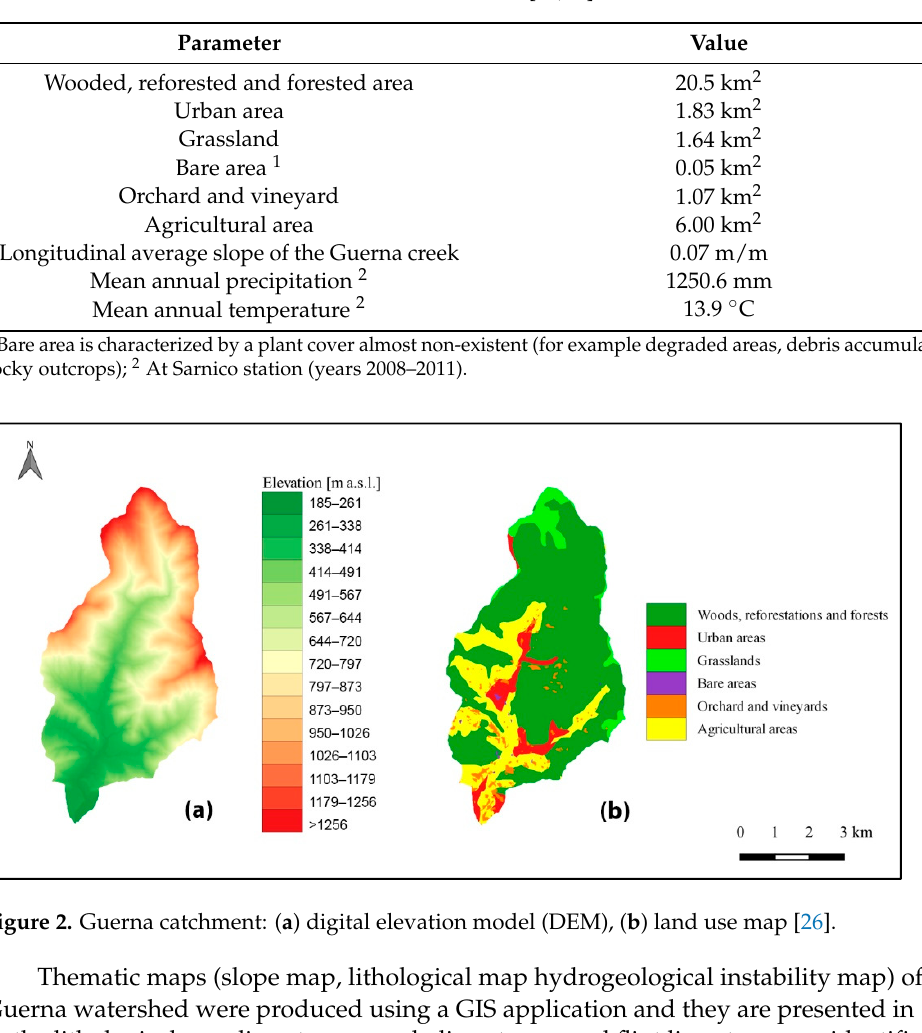
Figure 1. Guerna catchment site (North Italy). Source: Google Maps. Table 1. Characteristics of the Guerna creek catchment [26,27].